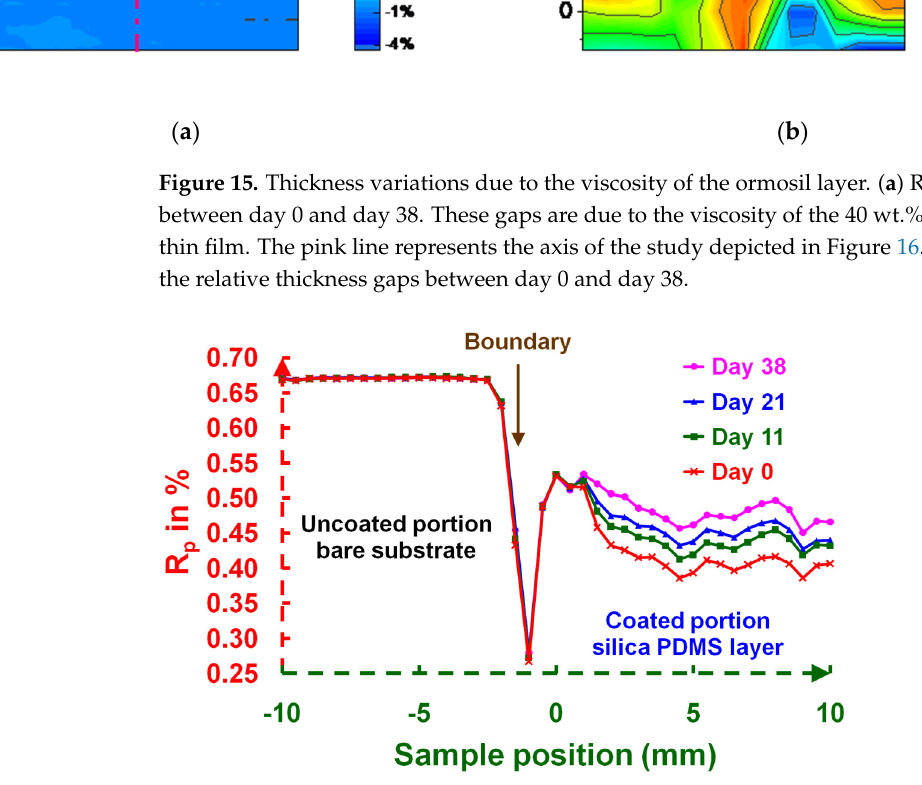
( b ) 2022. Figure 18. Maps of the same thin film (40 wt.% PDMS-based ormosil) at two different dates: ( a ) in 2021 and ( b ) in 2022. The sample was stored in a horizontal position.